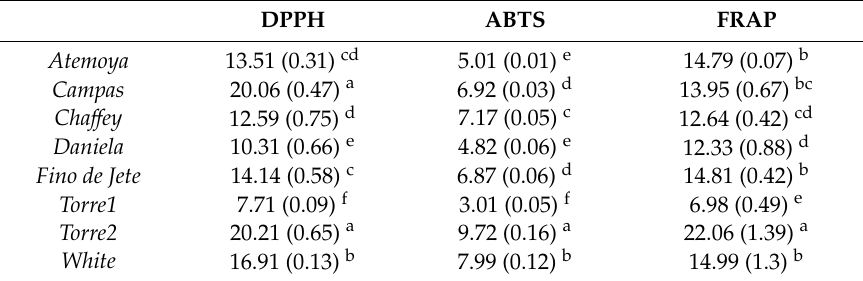
Table 3. Radical scavenging activity (ABTS and DPPH) and ferric reducing antioxidant power (FRAP) of the seven extracts of Cherimoya and Atemoya leaves. Values are expressed as mean ( ± SD) of three experiments carried out in